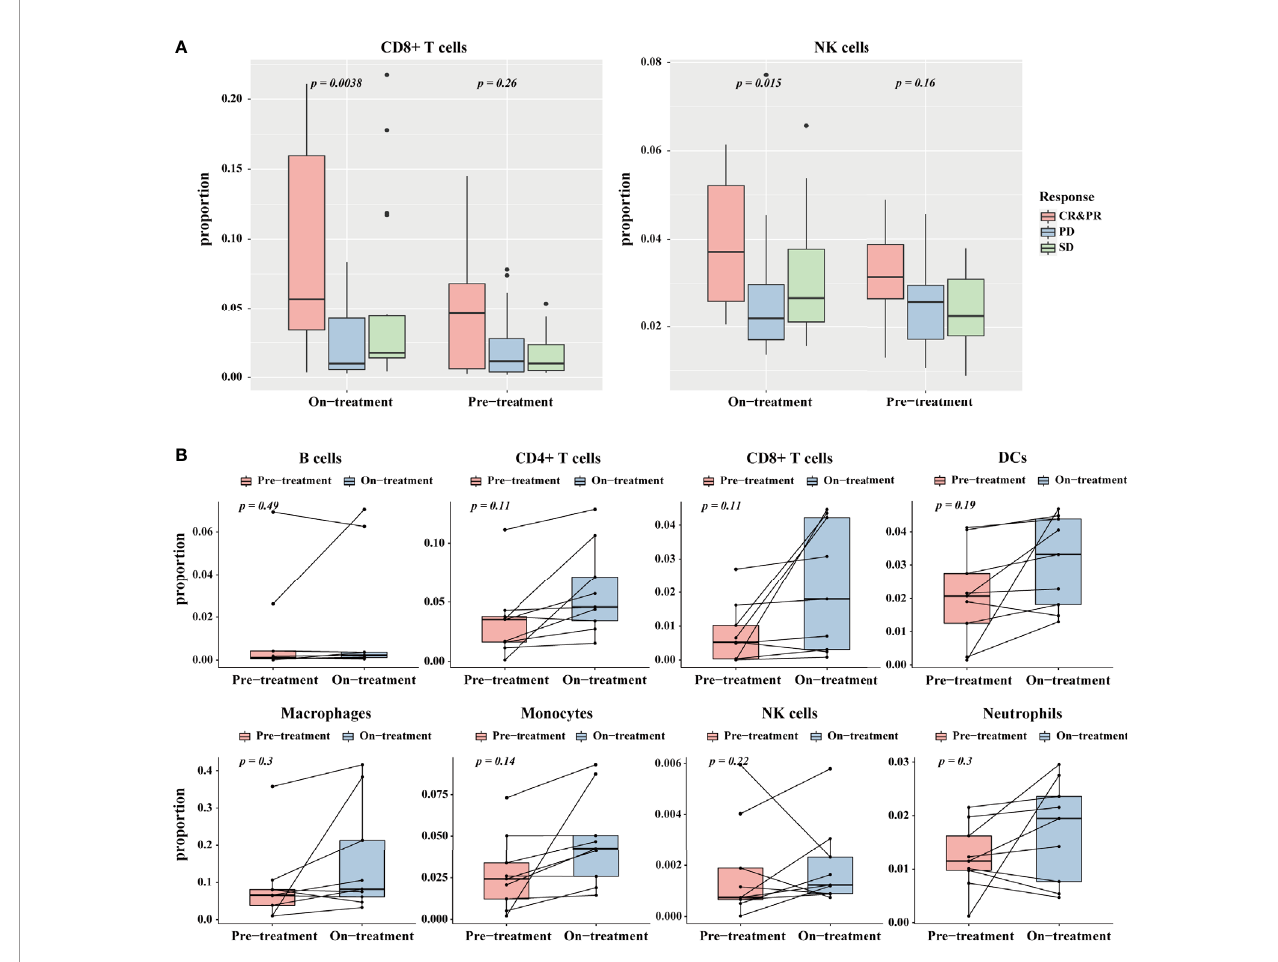
FIGURE 5 | The application of TICPE on immunotherapy for melanoma. (A) The signi fi cant proportion differences of CD8+ T cells (left)/NK cells (right) in different response groups at pre- and on-treatment (anti-PD1) time point. (B) Change of the estimated immune cell proportions between pre-treatment and on-treatment time point in paired